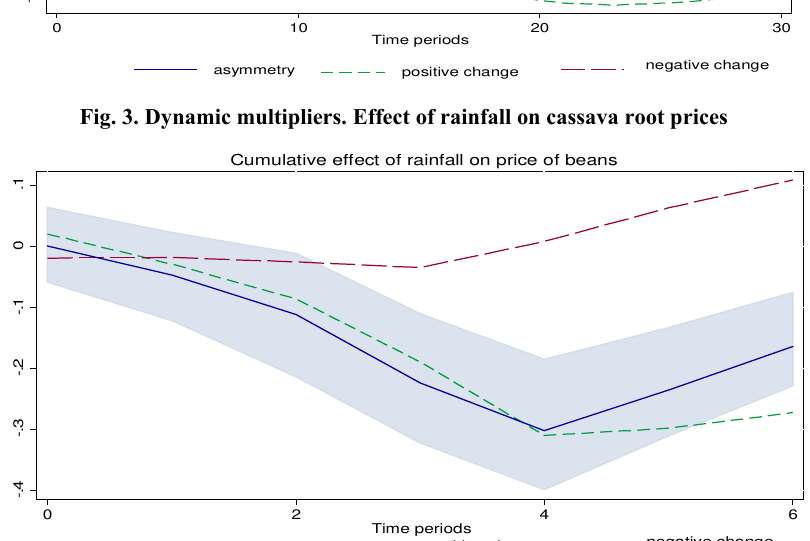
Fig. 4. Dynamic multipliers. Effect of rainfall on bean prices